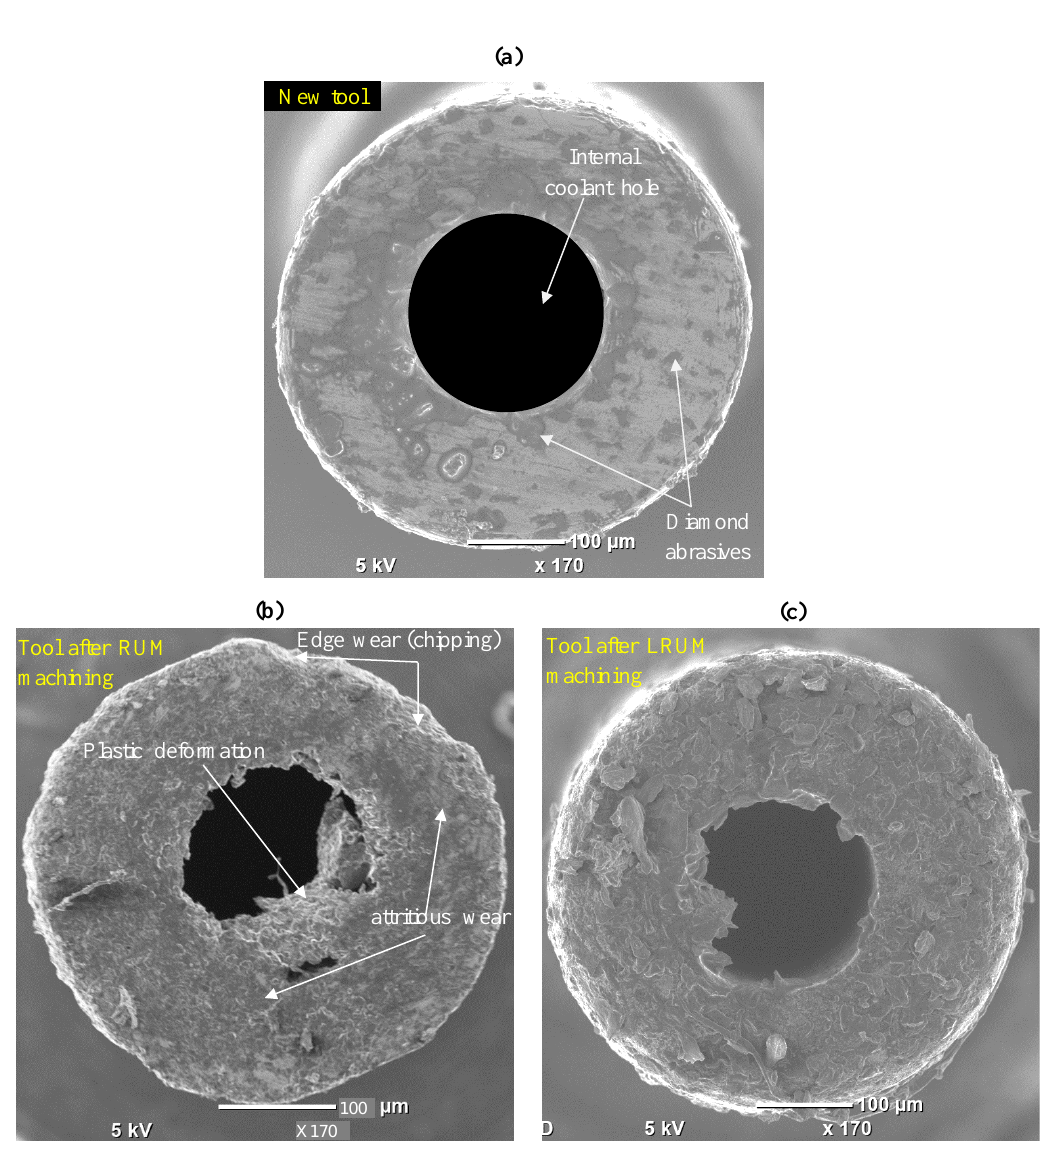
Figure 17. Comparison of the RUM tool ( a ) before machining (new tool), ( b ) after machining by using RUM, ( c ) after machining by using LRUM.